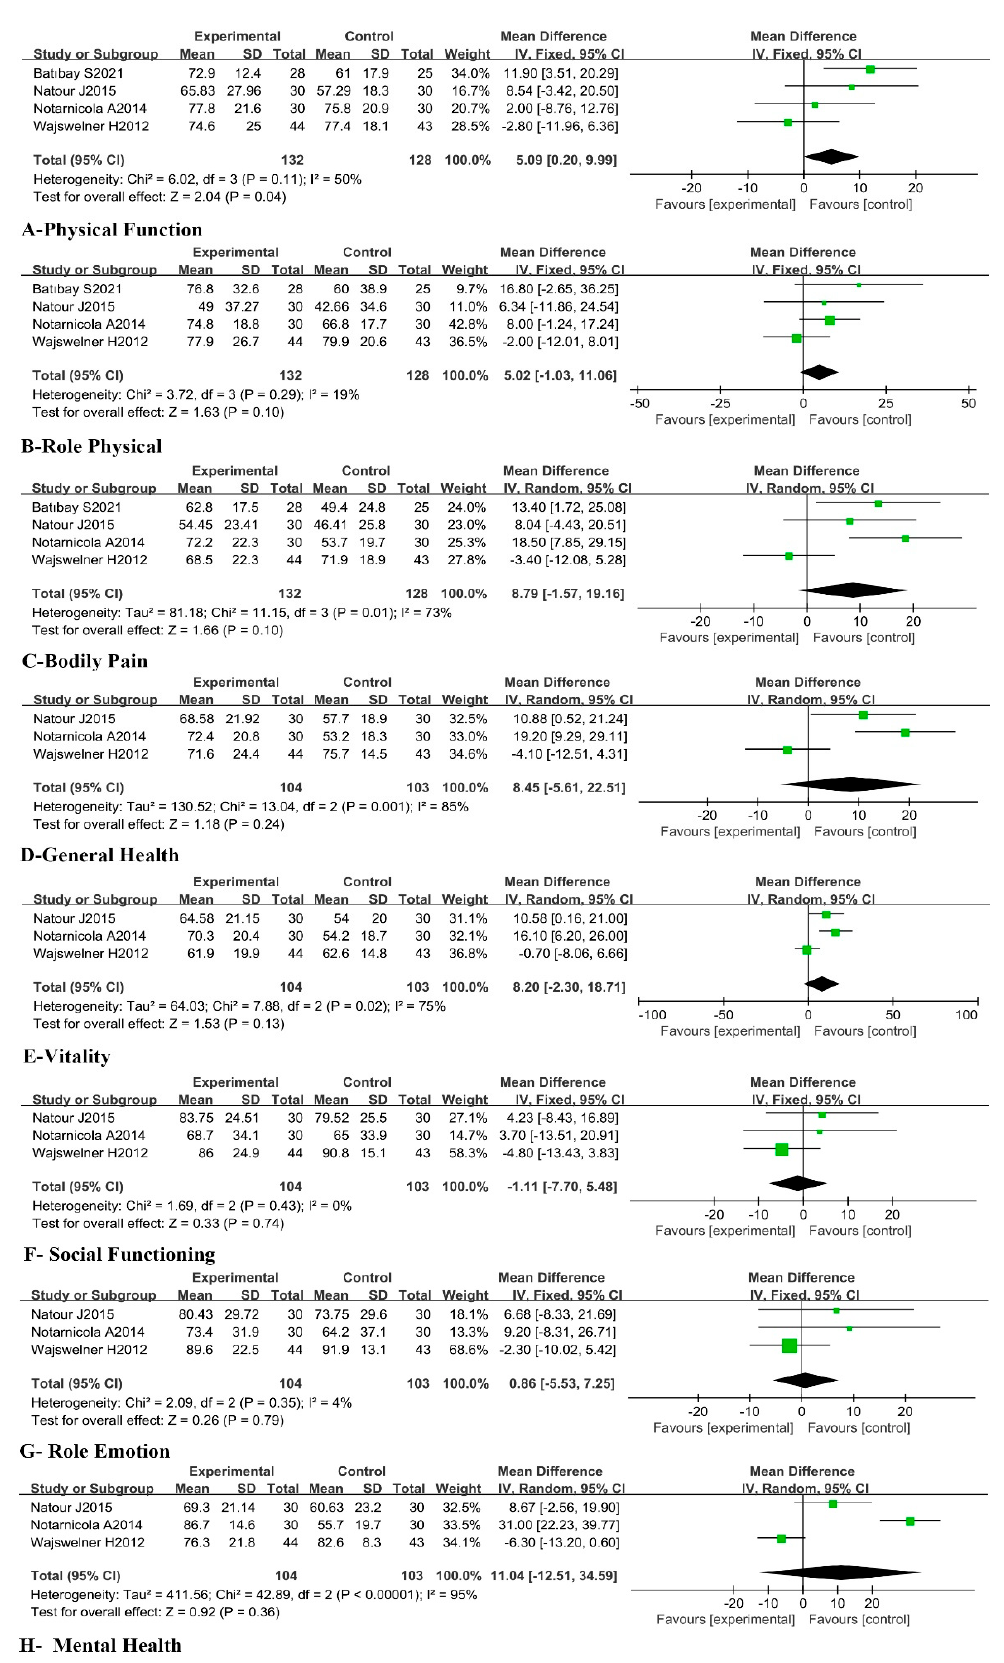
Figure 7. Meta-analysis of the effect of Pilates on eight dimensions of SF-36 in CLBP patients [45,46,48,53].